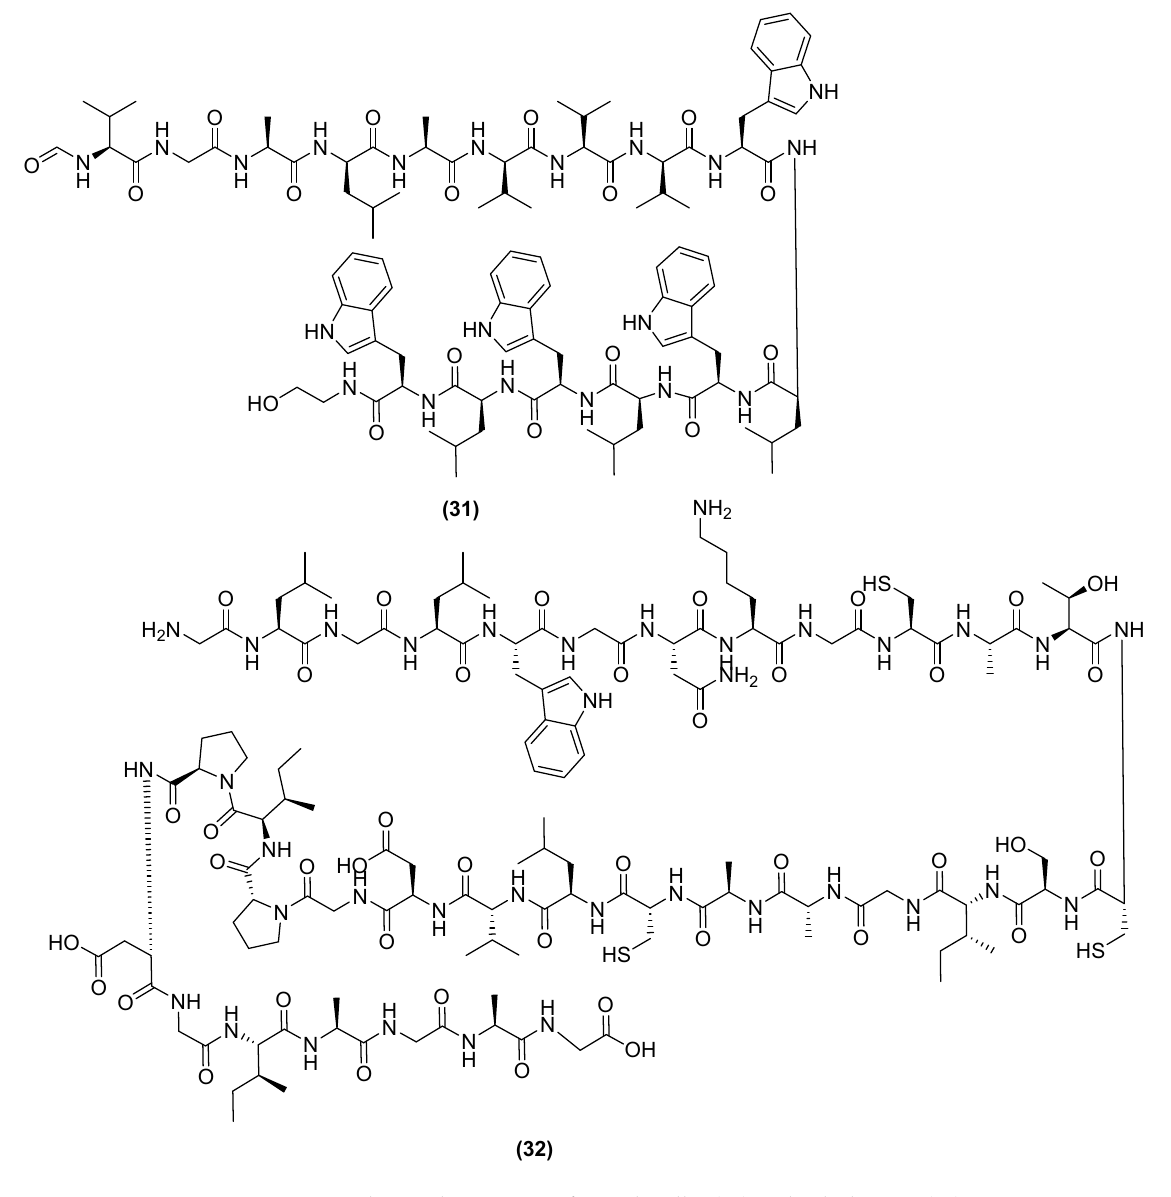
Figure 8. Chemical structures of mycobacillin ( 31 ) and subtilosin A ( 32 ).